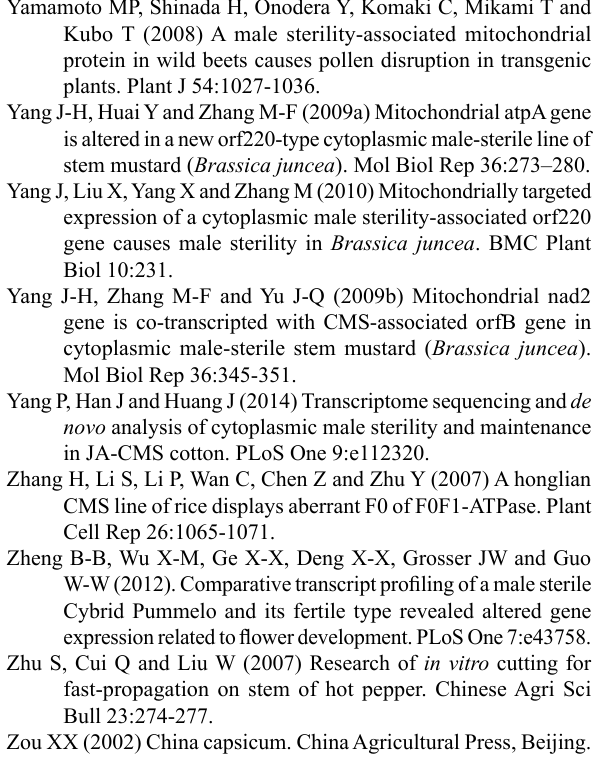
Figure S2 ‒ Size distribution of EST obtained from the ESTScan results. Figure S3 ‒ COG function classification of unigenes. Figure S4 ‒ GO function classification of unigenes. Figure S5 ‒ Histogram of GO classifications for differentially expressed genes. Figure S6 ‒ Multiple alignment of DNA sequences of orf165 and orf507 . Figure S7 ‒ PCR and expression analysis of orf165 expression in 17 transgenic